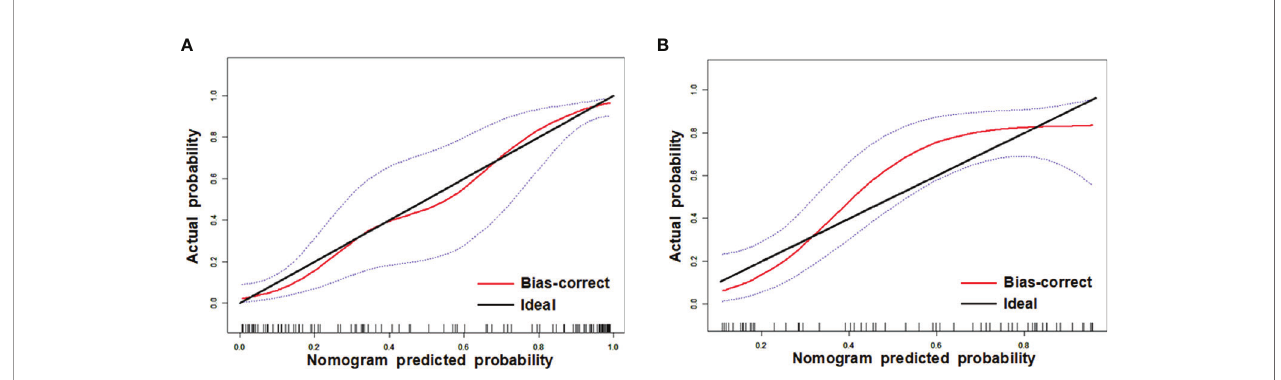
FIGURE 5 | Calibration curves of training (A) and test (B) datasets. The y axis shows the patients ’ real VEGF positivity rate, while the x axis shows the nomogram- forecasted likelihood of VEGF positivity. The black slant solid line denotes a faultless agreement as determined by an ideal model. The blue dashed lines represent 95% con fi dence interval [CI].